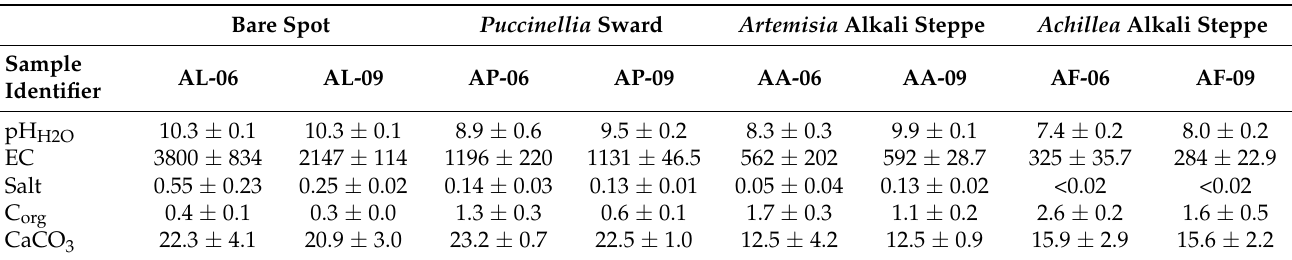
Table 2. Physical and chemical parameters of the sodic soil samples from different alkali vegetation types in June (06) and in September (09). Data represent the mean values ± S.D ( n = 3). Bare Spot Puccinellia Sward Artemisia Alkali Steppe Achillea Alkali